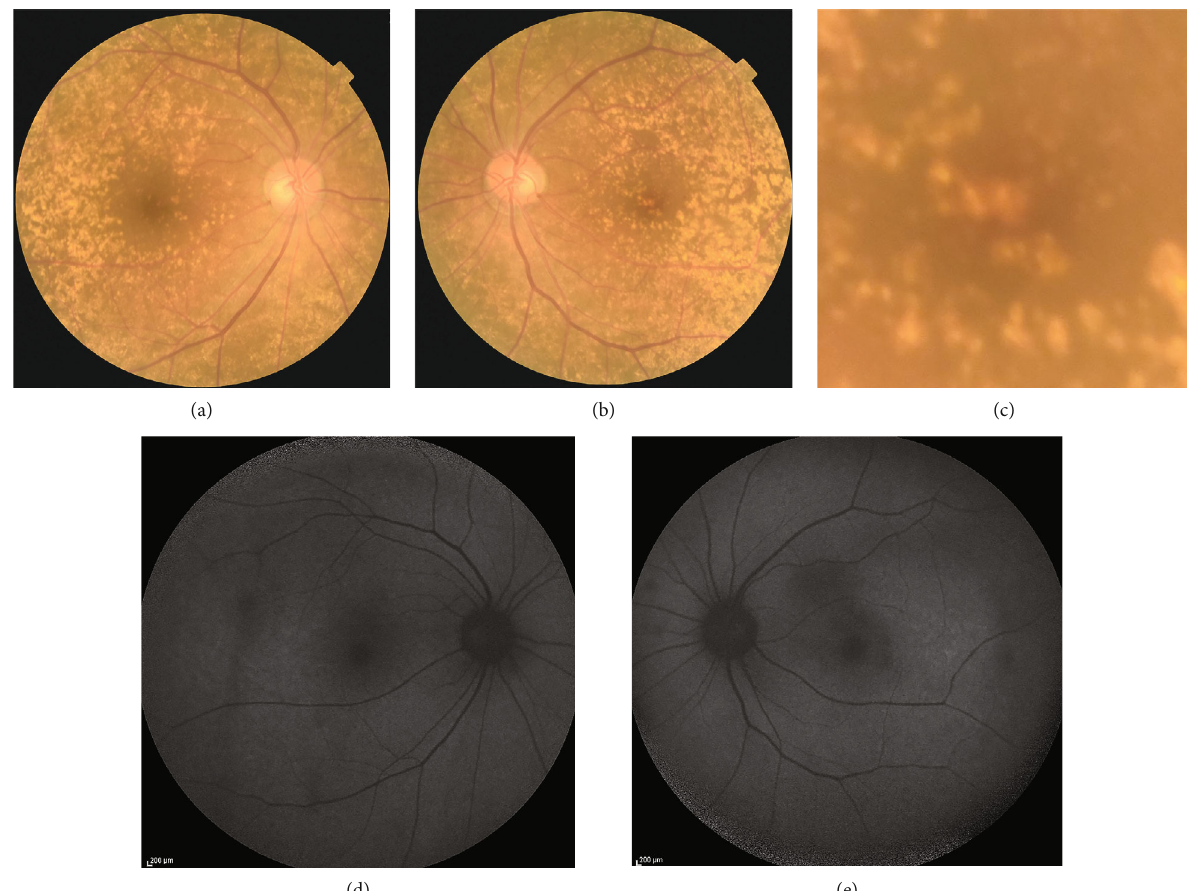
Figure 1: Color fundus photographs of the right (a) and left (b) eyes and the left macula (c). Fundus auto fl uorescence of the right (d) and left (e)